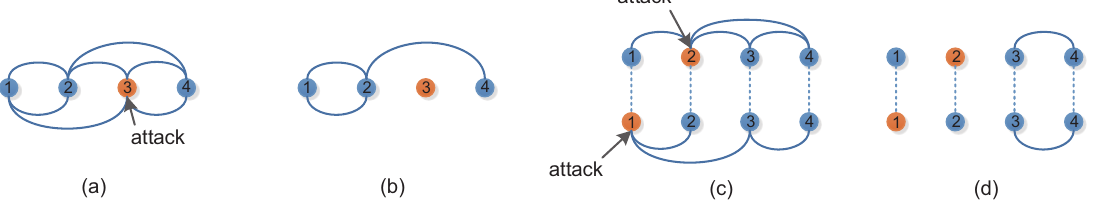
Figure 1. Multiplex node-based attack ( a ) and layer node-based attack ( c ) in the illustrative examples of the multiplex network. The edges in the top and bottom represent different kinds of edges. The two networks after different attacks are given in ( b , d )